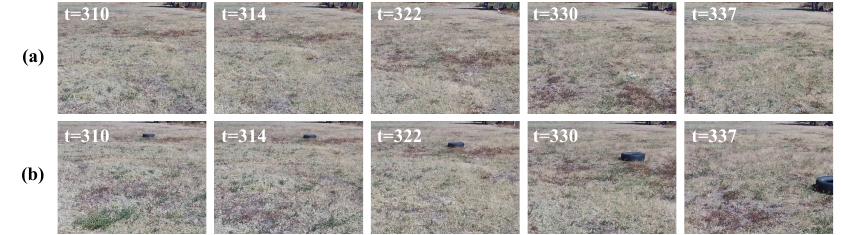
Figure 13. Sample image frames labeled as novelty images by the evolved SECoS detector in the inspection phase: ( a ) sample images frames used to learn the model of the environment, and ( b ) sample images detected as novelty in the inspection phase.